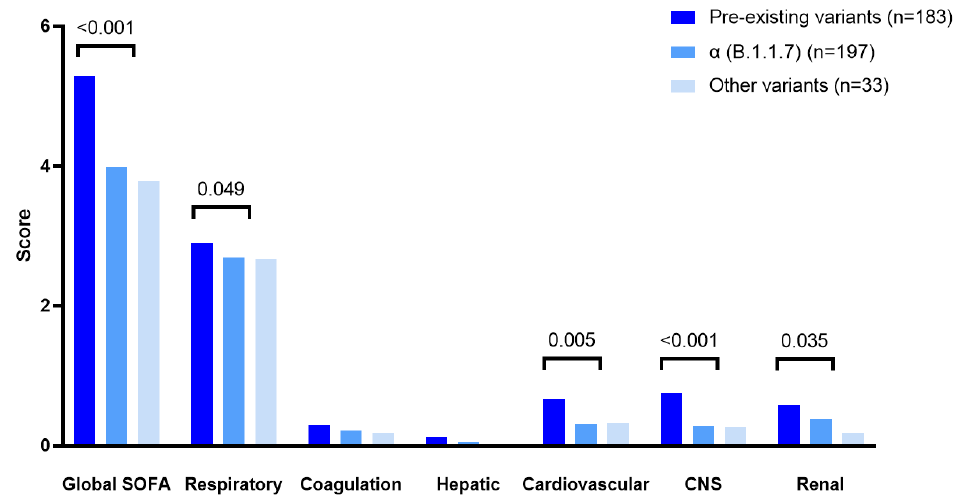
Figure 2. SOFA score and its organ system components in patients with pre-existing, α (B.1.1.7), or other variants. The p values are from ANOVA.